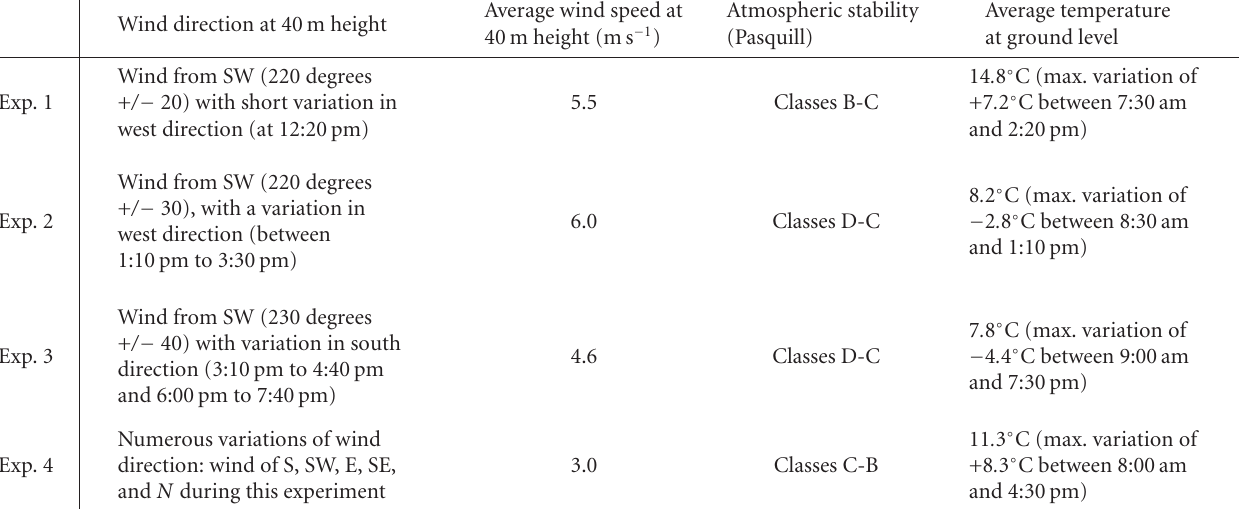
Table 3: Average weather conditions during the SF6